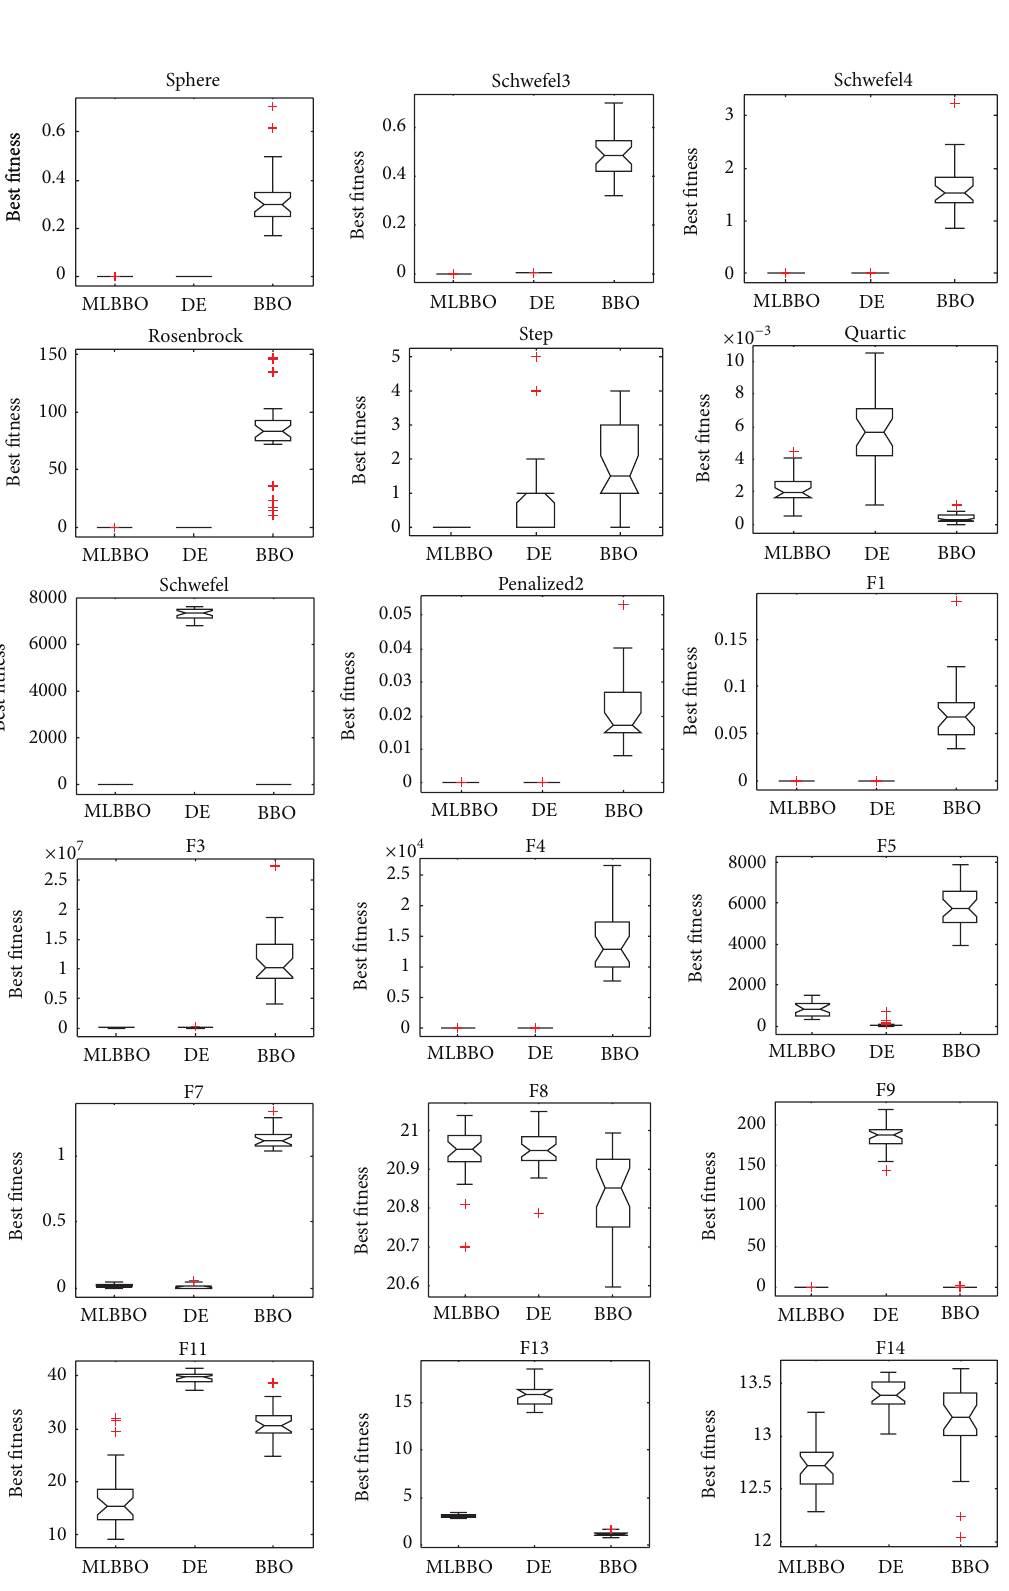
Figure 3: ANOVA tests of fitness values of MLBBO, BBO, and DE for functions f1, f2, f3, f5, f6, f7, f8, f13, F1, F3, F4, F5, F7, F8, F9, F11, F13, and